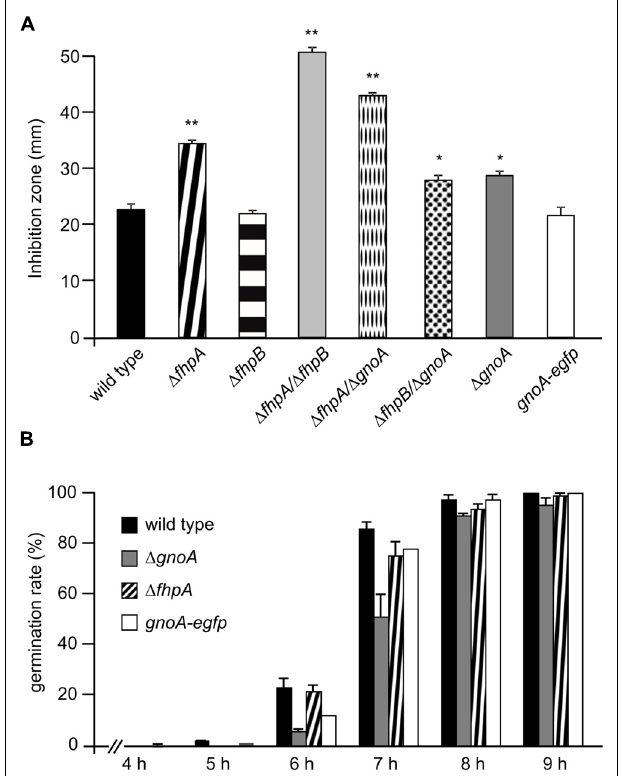
FIGURE 2 | Phenotypical characterization of mutant strains. (A) Sensitivity of A. fumigatus strains against DETA-NO.The inhibition zones in a plate diffusion assay were measured 16 h after addition of 45 μ M DETA-NO. p- values are indicated by asterisks; ∗ p < 0.05; ∗∗ p < 0.01. (B) Germination rate of the wild type and the (cid:2) fhpA and (cid:2) gnoA mutant strains.The ratio of germinated to non-germinated spores was calculated based on light microscopical inspection at the time points